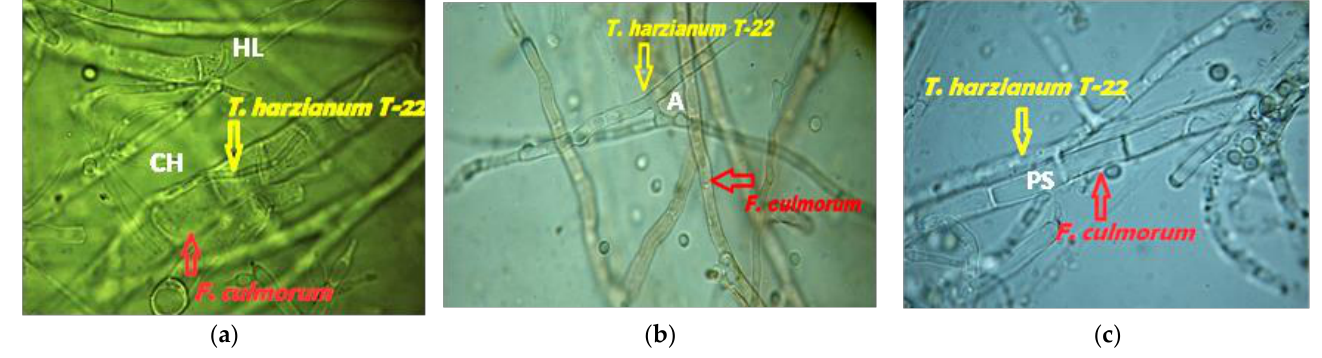
Figure 1. Front ( a ) and back ( b ) plate showing the interaction between T. harzianum T-22 (on the left) and F. culmorum (on the right) at 14 days post inoculum.